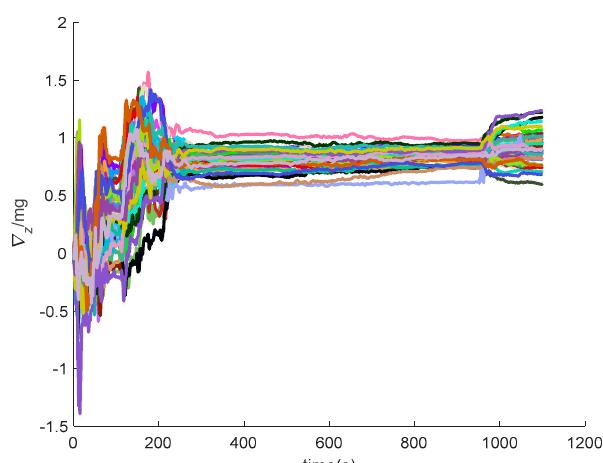
/ GPS in the LCEF frame.